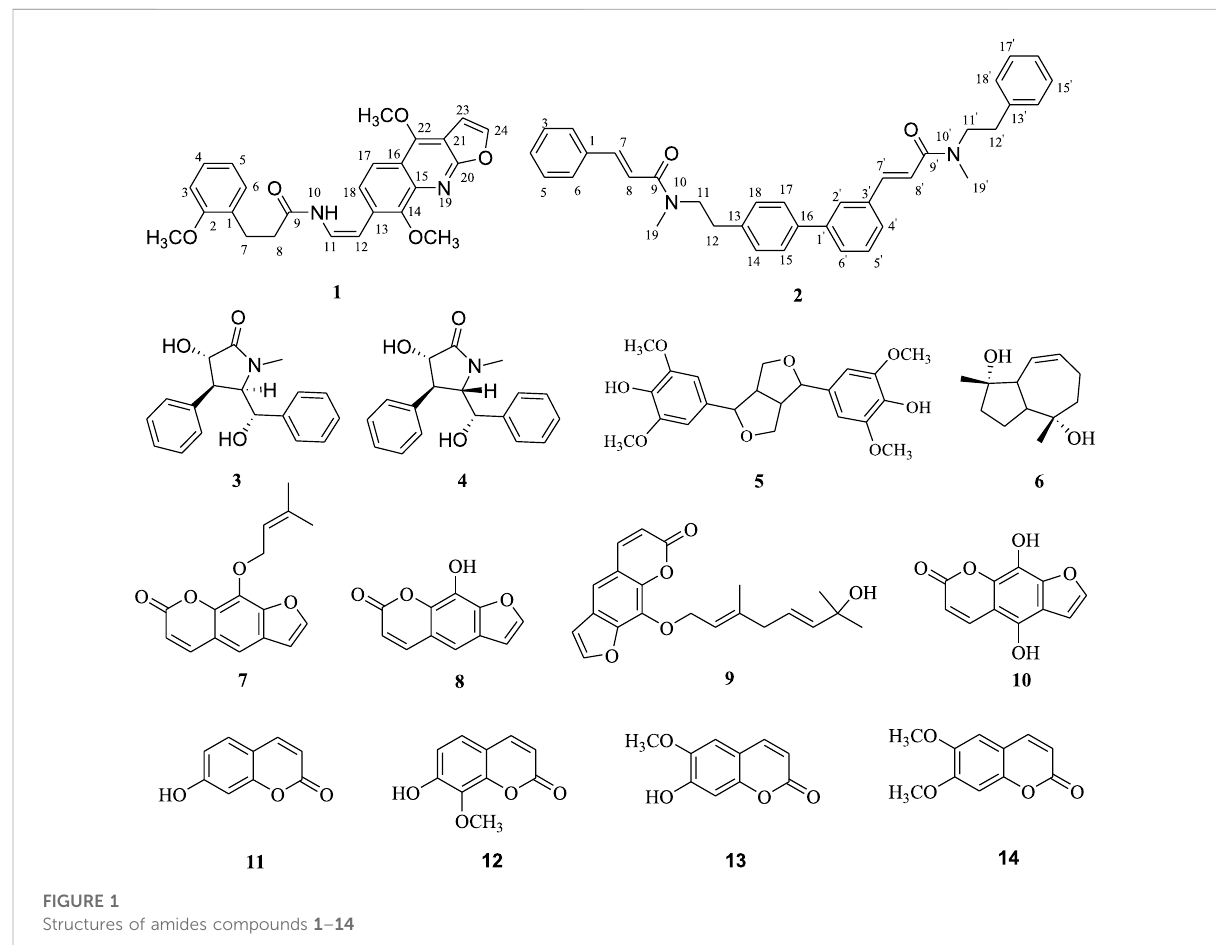
FIGURE 1 Structures of amides compounds 1 –